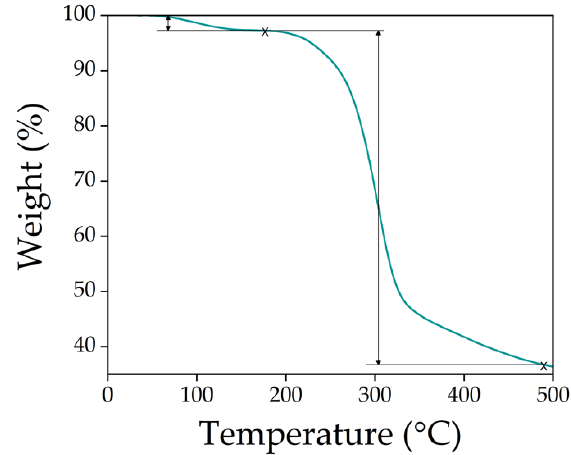
Figure 4. TGA curve of DCMC under argon atmosphere at 10 °C min −1 heating rate.